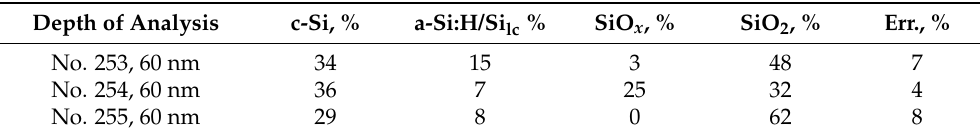
Figure 3. USXES Si L 2,3 -spectra of ( a ) porous silicon samples with different porosity and ( b ) spectra of the reference silicon phases. Dashed line—experimental spectrum, solid line—simulated spectrum. Table 2. Distribution of the components of the phase composition as a relative percentage for the samples of porous silicon.